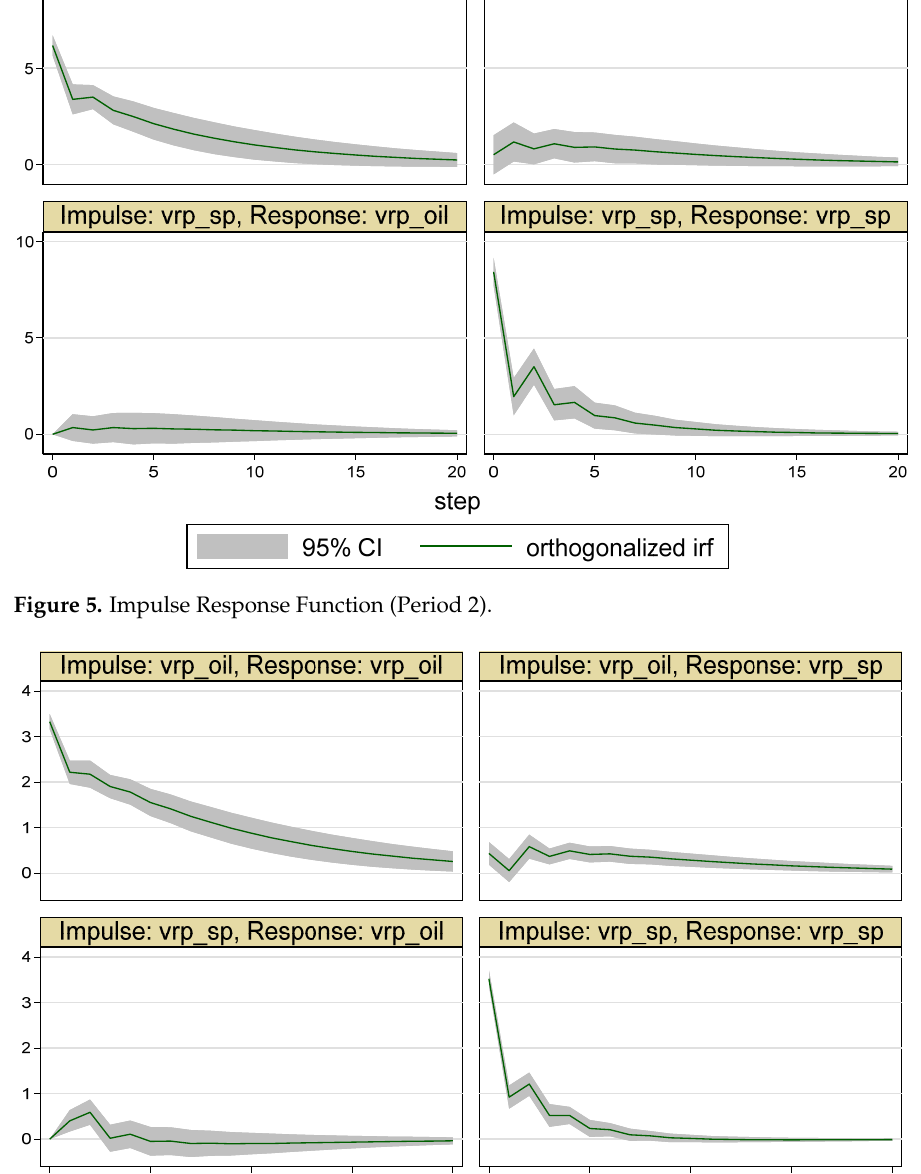
Figure 4. Impulse Response Function (Period 1).